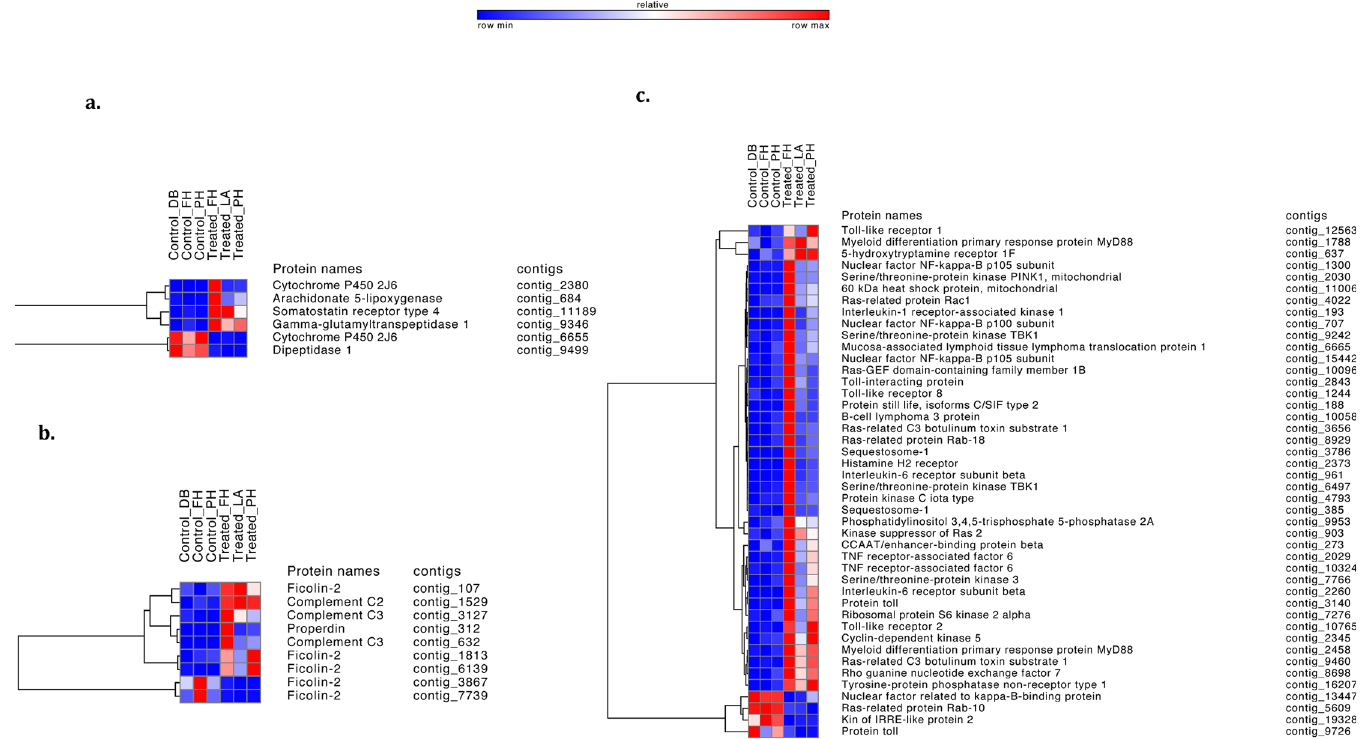
Fig 3. Immune related pathways heatmaps. Heatmaps of immune-related differentially expressed transcripts between control and treated sea stars. Heatmaps are subdivided by related pathway (a) Arachidonic acid metabolism (b) Complement cascade (c) Toll-mediated pathways. Increased expression is shown in red and decreased expression is shown in blue.